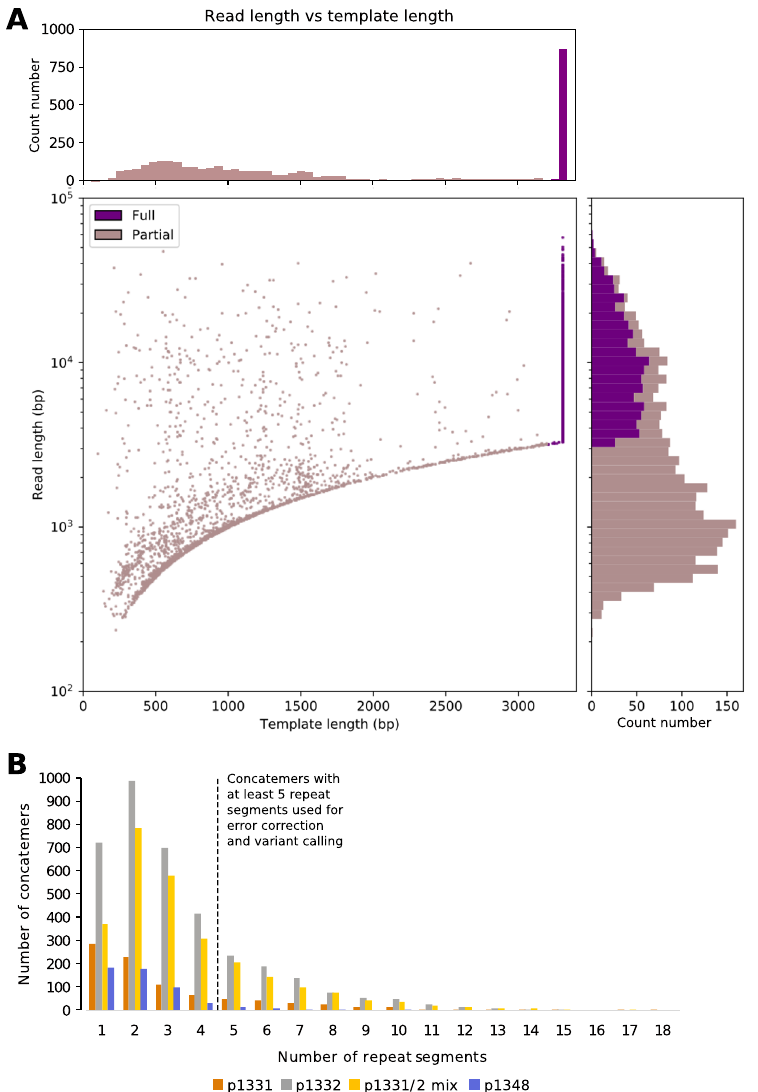
Figure 3. HBV sequence data generated by Nanopore sequencing following completion/ligation (CL) of the genome and rolling circle amplification (RCA). ( A ) Read length and template length of all reads generated from sample 1331. ‘Template length’ refers to the length of the primary alignment of the read, based on a concatenated reference genome. Template length is capped at 3.3 kb. Reads with alignments ≥ 3.2 kb in length are considered ‘full length’ concatemers; these are shown in dark purple. ( B ) Plot to show the number of repeat segments in ‘full length’ concatemers. This is equal to the number of segments that a read is chopped into based on the repeated location of an anchor sequence (see methods for details). Reads with ≥ 5 repeat segments will contain ≥ 3 full length copies of the HBV genome, as shown in Fig. 1C. These are taken forward for error correction and further